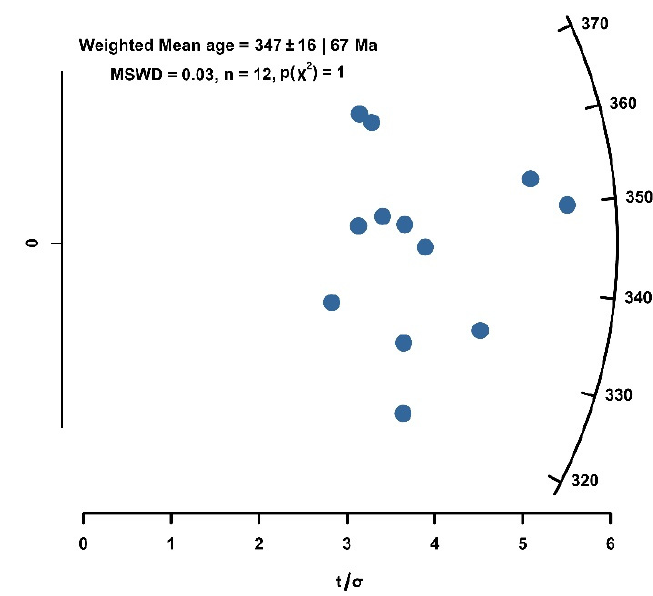
Figure 6. Radial plot diagram [86] for all dated ZFT grains. Table 4. Zircon fission-track ages. Gr.